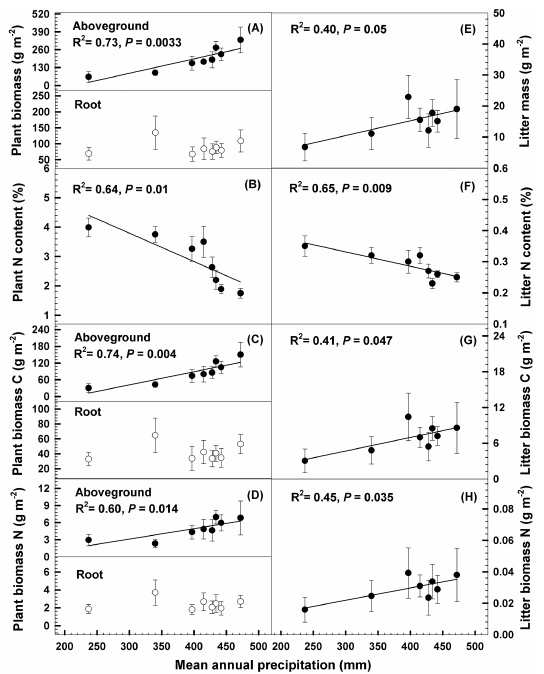
Figure 2. Patterns of aboveground and root biomass ( a ), plant N content ( b ), aboveground and root biomass C ( c ), aboveground and root biomass N ( d ), litter mass ( e ), litter N content ( f ), and litter biomass C and N ( g, h ) along the precipitation gradient in native Leymus chinensis grasslands of northeastern China.